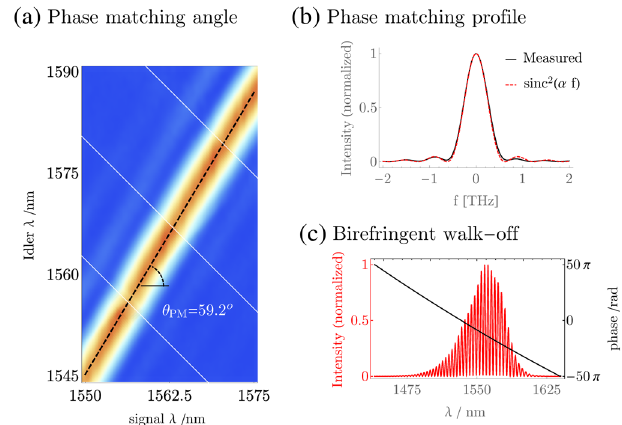
FIG. 13. Group-velocity-mismatch characterization. (a) Meas- urement of the phase-matching angle. Four low-gain JSIs with different pump central frequencies are joined to reconstruct a long section of the phase-matching function. (b) Inference of Δ μ by measuring the bandwidth of the phase-matching profile. The measured intensity profile (solid black line) is fitted with a sinc 2 function (dashed red line), and the group delay is obtained from Eq. (D7). (c) Direct measurement of Δ μ by measuring spectral interference between two orthogonal polarizations of a broad- band SLED after traveling through the crystal. The oscillating spectral intensity (red line) is transformed to the Fourier domain, and a corresponding spectral phase is obtained (black line), from which the spectral oscillation period is